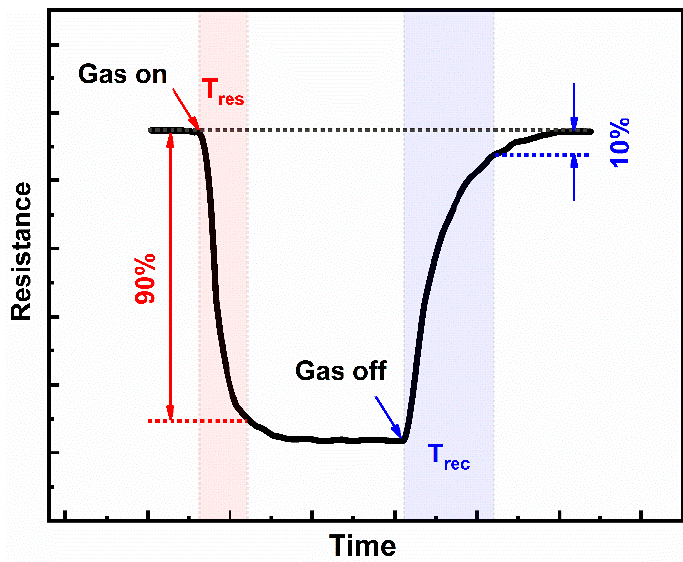
Figure 1. The response time and recovery time of a typical MOS gas sensor.